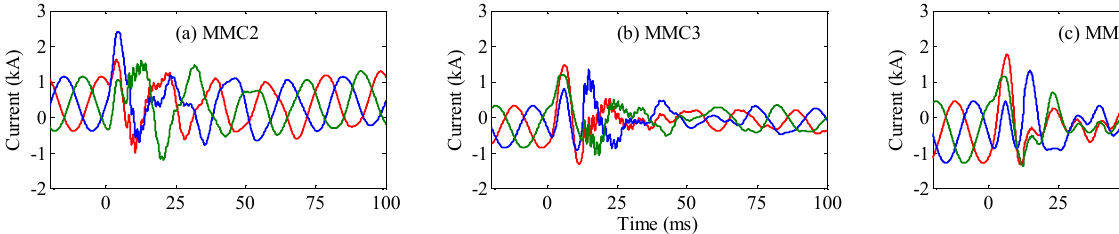
Fig. 10. The arm currents of MMCs in presence of BCBs (a) MMC2, (b) MMC3, (c) MMC4